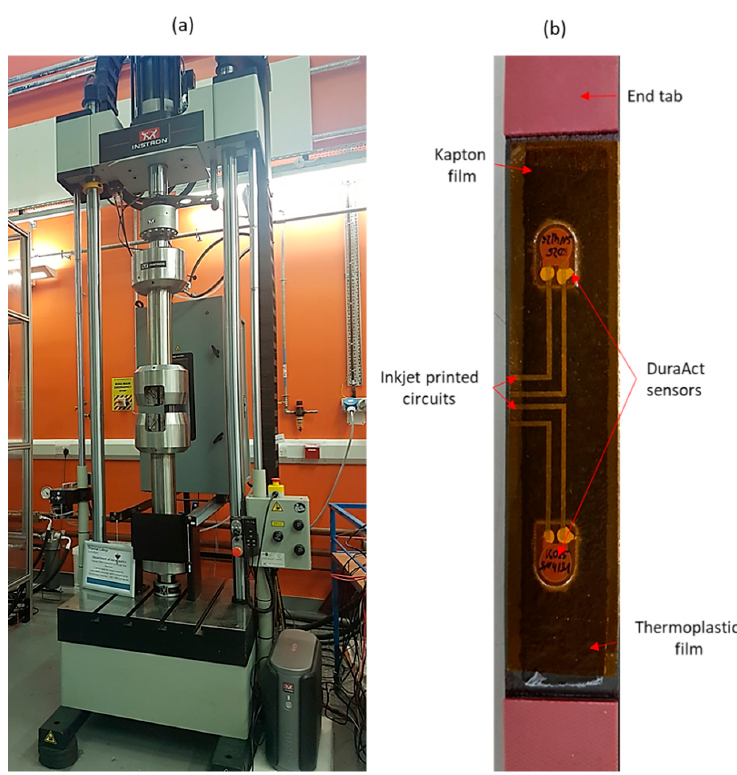
Figure 6. ( a ) INSTRON testing machine employed for mechanical fatigue testing of the diagnostic film; ( b ) carbon fiber reinforced polymer (CFRP) coupons with the surface-mounted diagnostic film.